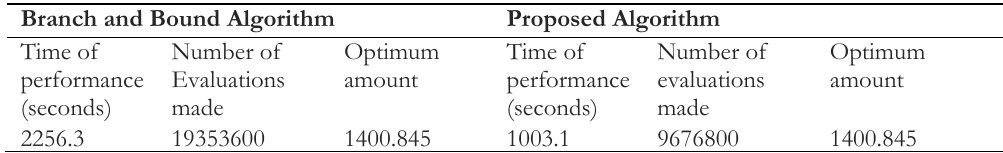
Table 4. Results of the two algorithms’ performance.